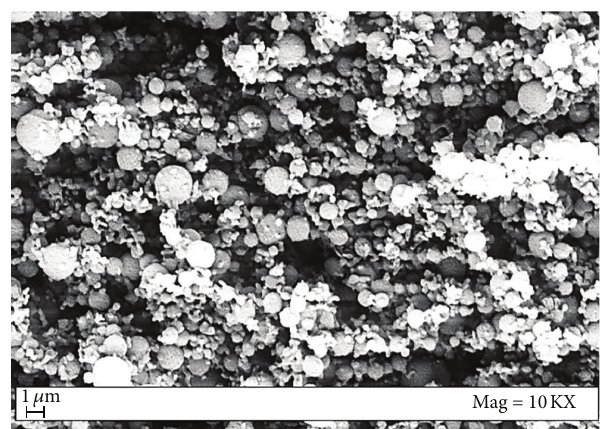
Figure 3: Dexamethasone microparticles obtained by SAA at 40 ∘ C and 76 bar in the saturator and 70 ∘ C and 1.6 bar in the precipitator.